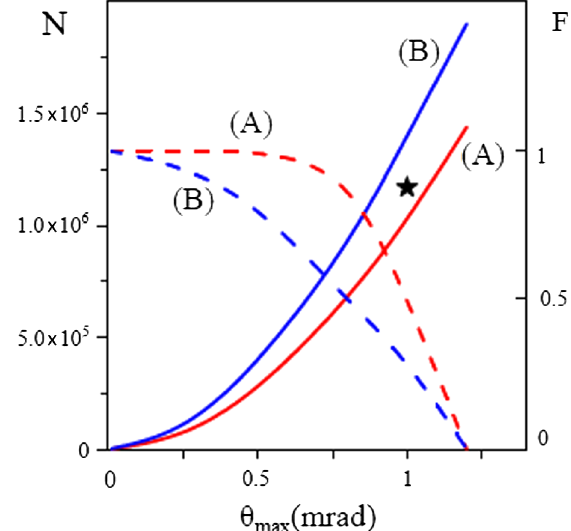
FIG. 6. Number of emitted photons N (solid lines) for beam (A) (red solid line) and (B) (blue solid line) and contrastF (dashed lines) as a function of the acceptance angle θ . max